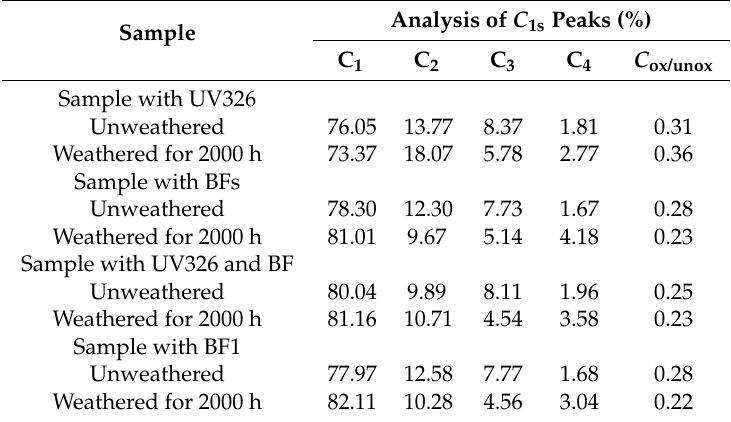
Table 4. Relative amount of different carbon-to-oxygen bonds at the sample surface determined by high-resolution